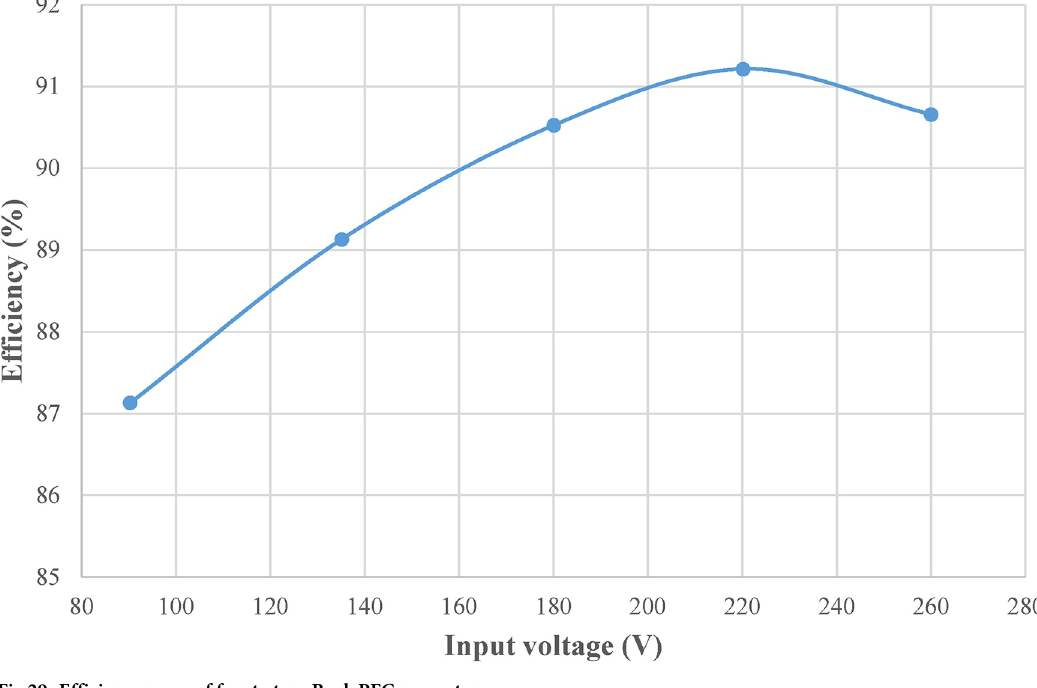
Fig 29. Efficiency curve of front-stage Buck PFC converter.